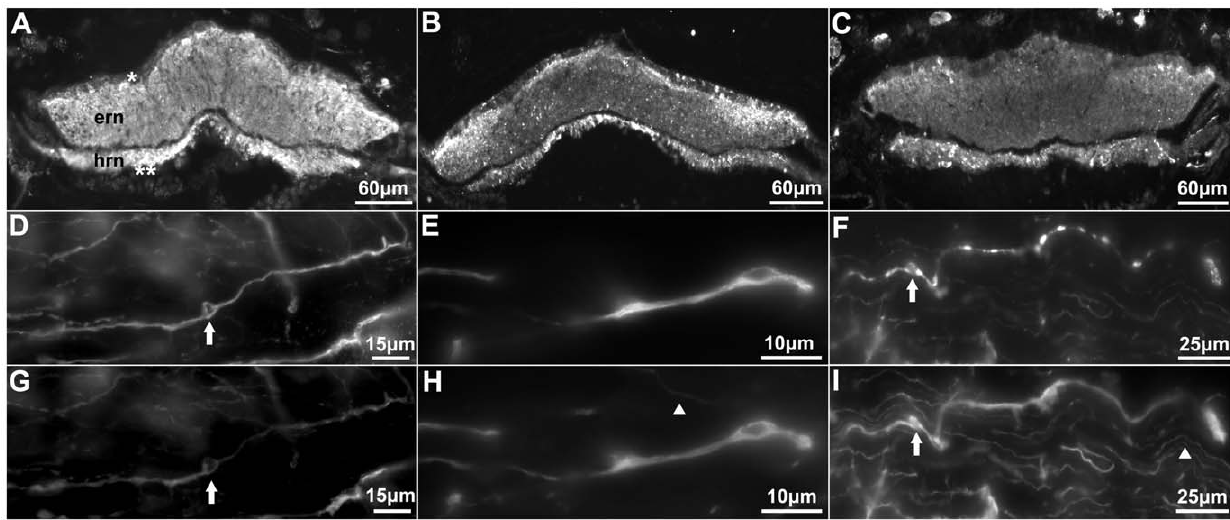
Figure 1. Anti-calbindin 1, anti-parvalbumin, and anti-calbindin 2 immunoreactivity in the nervous system of Holothuriaglaberrima (Holothuroidea). Transverse sections through the radial nerve cords showing immunoreactivity to anti-calbindin 1 (A), anti-parvalbumin (B), and anti-calbindin 2 (C) in the ectoneural and hyponeural components of the radial nerve. Double-labeling of anti-calbindin 1 (D) and RN1 (G), anti- parvalbumin (E) and RN1 (H), and anti-calbindin 2 (F) and RN1 (I) in cells (arrows) and fibers of the connective tissue plexus of the tube feet. Co- labeling is observed with the anti-CBPs markers and RN1 in the majority of the fibers, but not in all (arrowheads). ern, ectoneural component of the radial nerve cord; hrn, hyponeural component of the radial nerve cord; *, ectoneural component cell bodies; **, hyponeural component cell bodies.